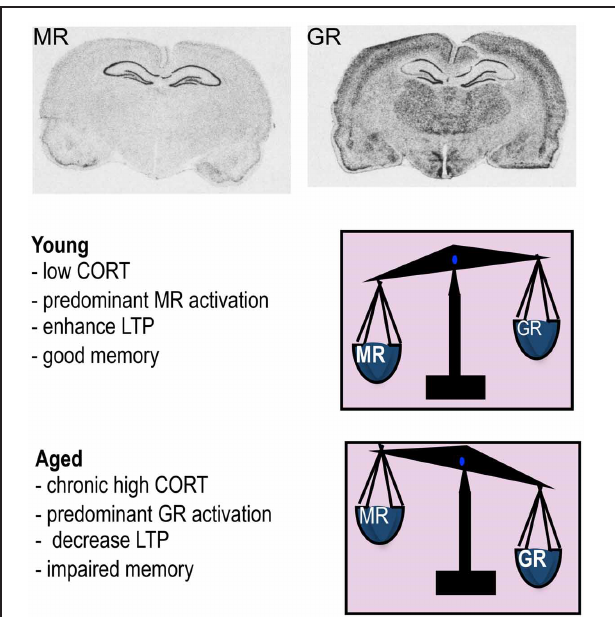
FIGURE 1 | Mineralocorticoid receptor (MR) and glucocorticoid receptor (GR) mRNA expression in rat brain. The high affinity MR is predominantly occupied under low corticosterone (CORT) levels typically observed in young animals under basal conditions and this leads to enhanced LTP and good memory. When CORT levels rises such as in aging, MR is fully occupied and the excess GCs now occupy more GR so the balance of receptors activated is now predominantly GR which decreases LTP and impairs